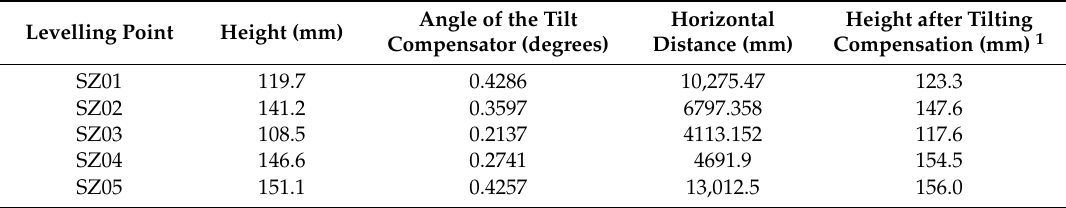
Table 2. The heights of the bar codes in the levelling line.